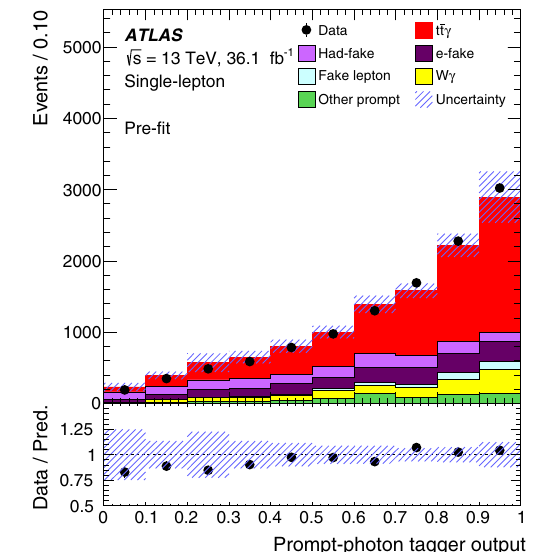
Fig. 3 Distributions of the output of the prompt-photon tagger in the single-lepton channel after event selection and before likelihood fit. All data-driven corrections and systematic uncertainties are included